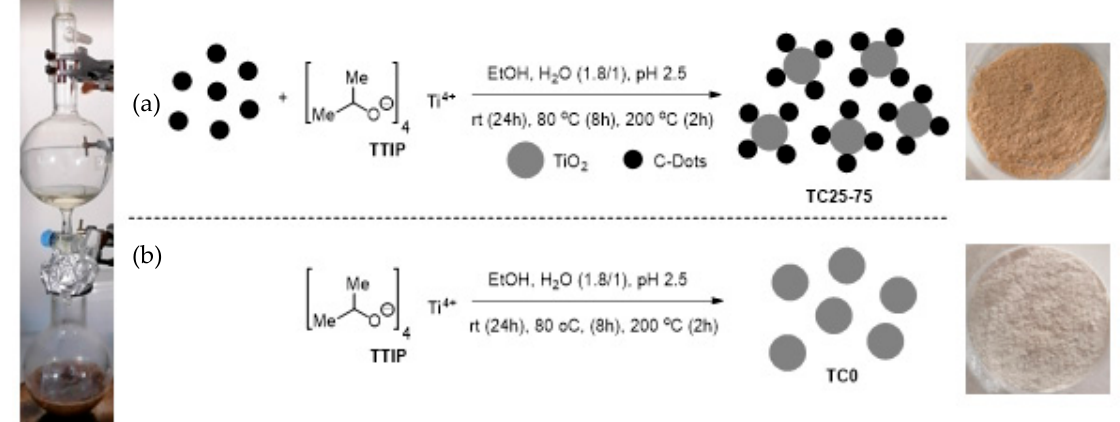
Figure 2. Synthesis of ( a ) TiO 2 enriched with C-dots (TC25–75) and ( b ) TiO 2 (TC0).